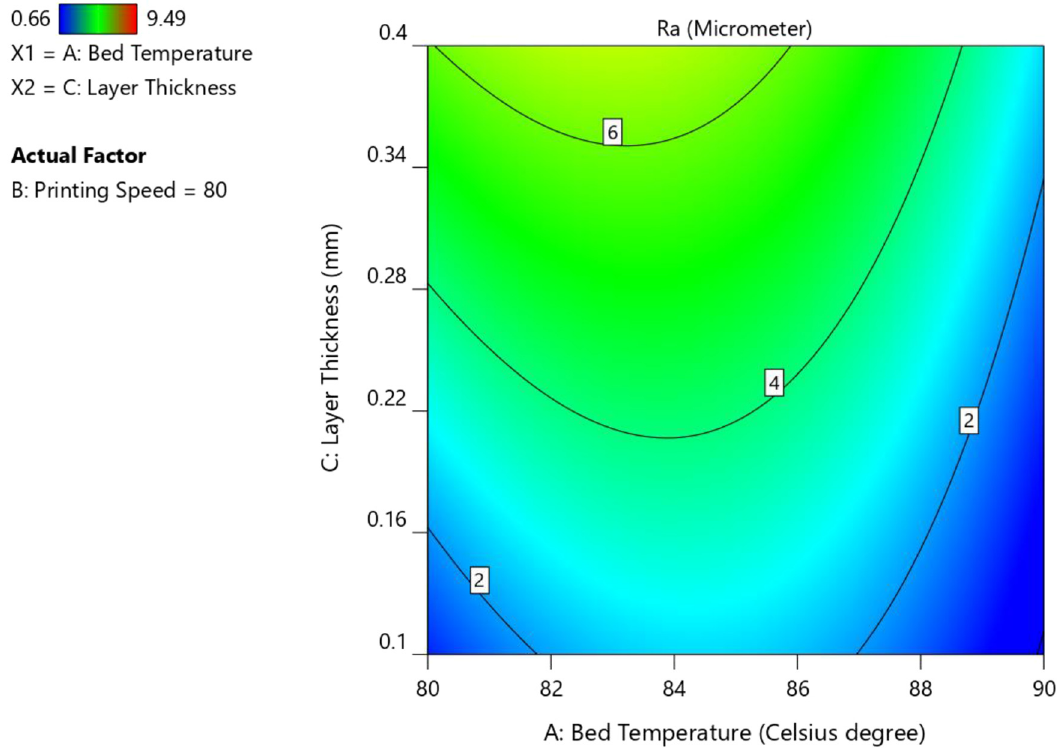
Fig. 12. Interaction plot between bed temperature (A) and layer thickness (C).